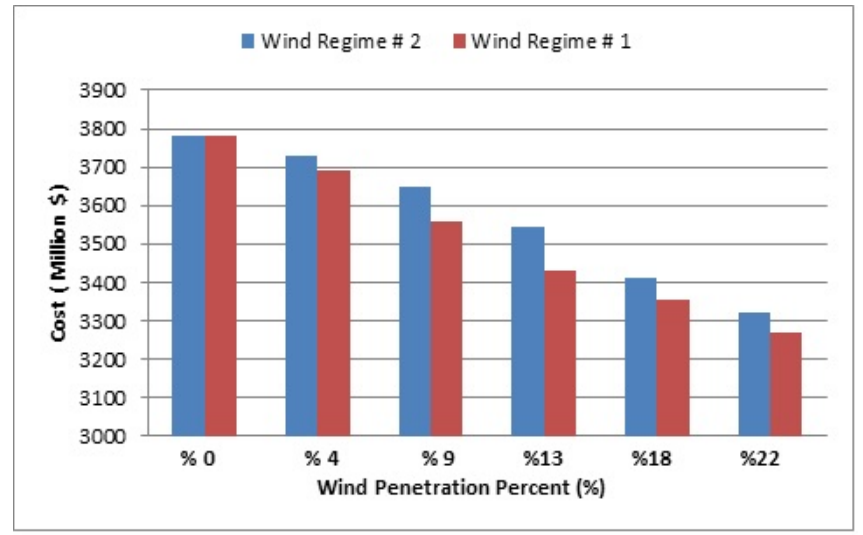
Figure 4. Reducing the operational cost of wind penetration plans in the system.